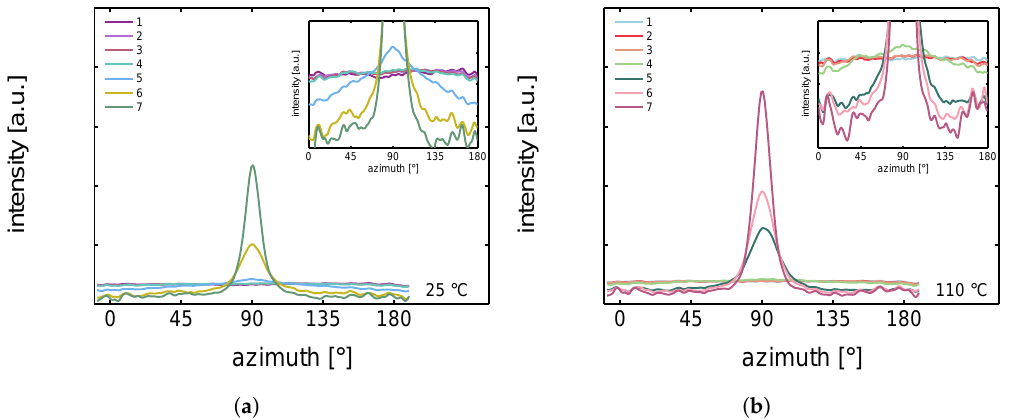
Figure 16. Azimuthal spread of the (111) diffraction of γ -iPP at various strains. ( a ) uni-axial stretching at 25 ◦ C and ( b ) 110 ◦ C. The numbers in the legend correspond to the 2D patterns in Figure 15. In Figure 17 the results of radial integration of the patterns measured on all crystal phases, stretched at testing temperatures of 25 and 110 ◦ C are plotted as a function of the scattering vector q and the true strain (cid:101) true . At 25 ◦ C the reflections of α - and γ -iPP become less intense and broaden, particularly in the macroscopic softening region, corresponding to true strains of about 0.2 to 2 [-]. The β -crystals, on the other hand, seem to maintain their crystallographic structure, and the biggest change observed is broadening of the peaks. At 25 ◦ C and high strain, α - and γ -iPP eventually transform into a 1D intensity typical for the mesophase. In the figures corresponding to elongation at 110 ◦ C it is evident that the α -reflection seems to be maintained rather well, whereas for β and γ -iPP the characteristic reflections disappear, simultaneously with the appearance of the α -reflection. The reflections remain sharp with well defined peaks up to high true strains.